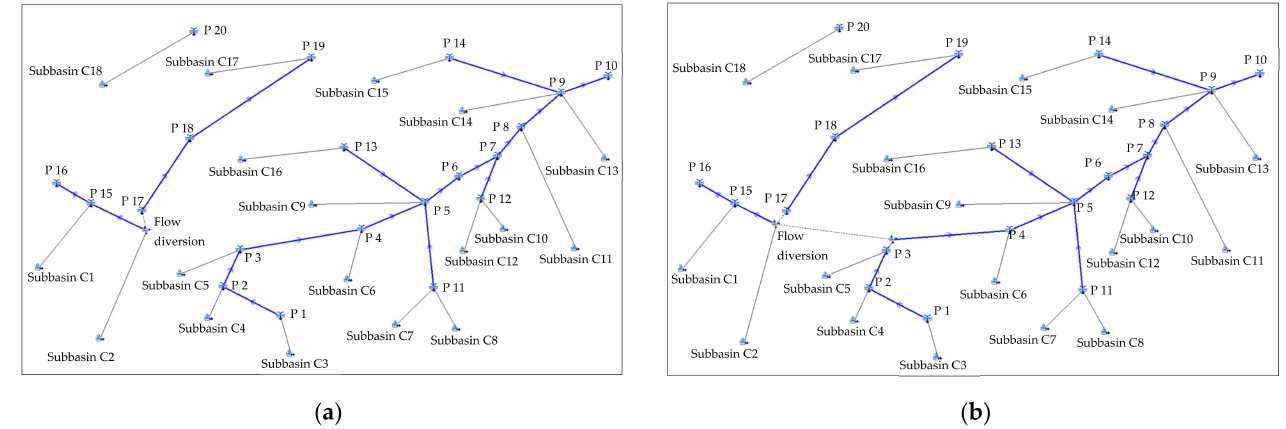
Figure 7. Hydrological model using HecHMS: ( a ) Model for return periods not higher than 100 years; ( b ) Model for a return period of 500